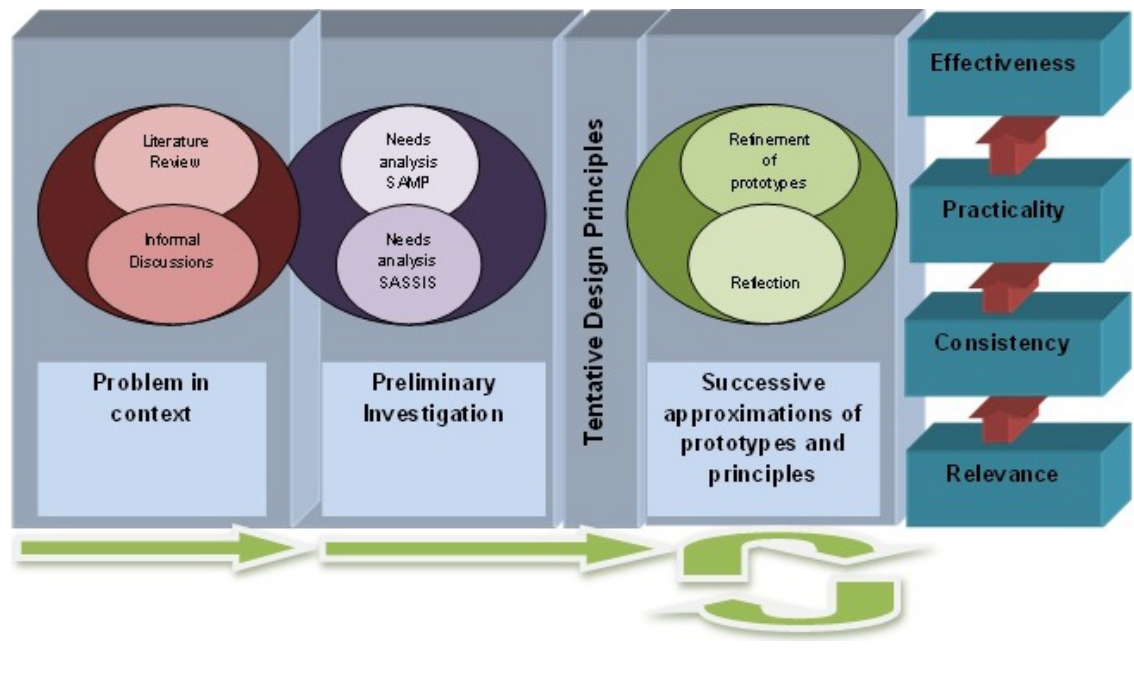
Figure 1 Design research